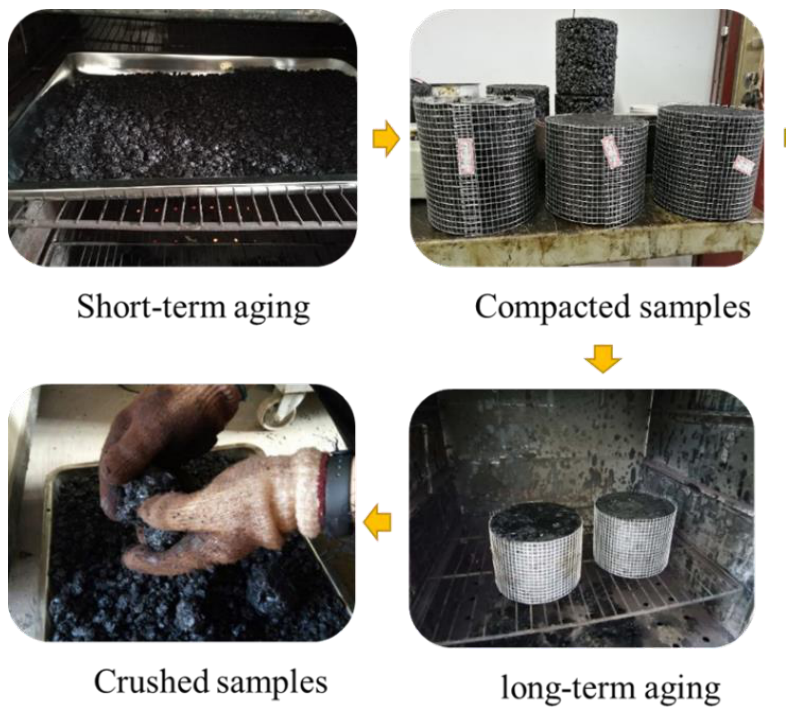
Figure 4. The process illustrating RAP production.